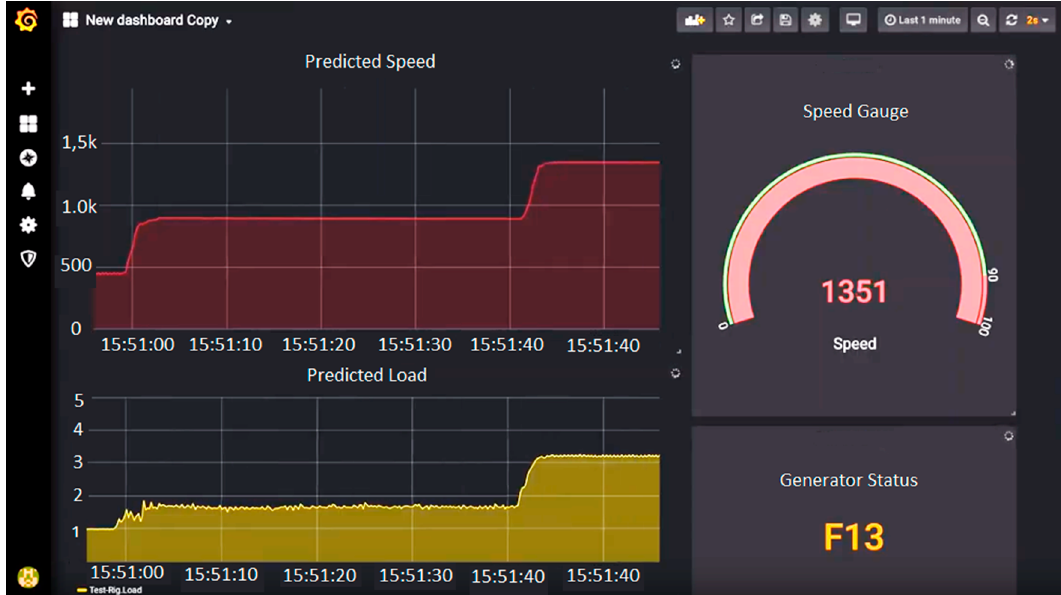
Figure 15. A screenshot of the Grafana interface graphing predictions in real time.